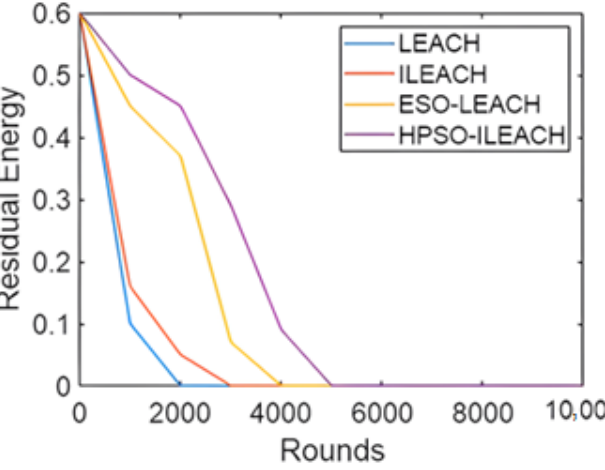
Figure 13. Residual energy.